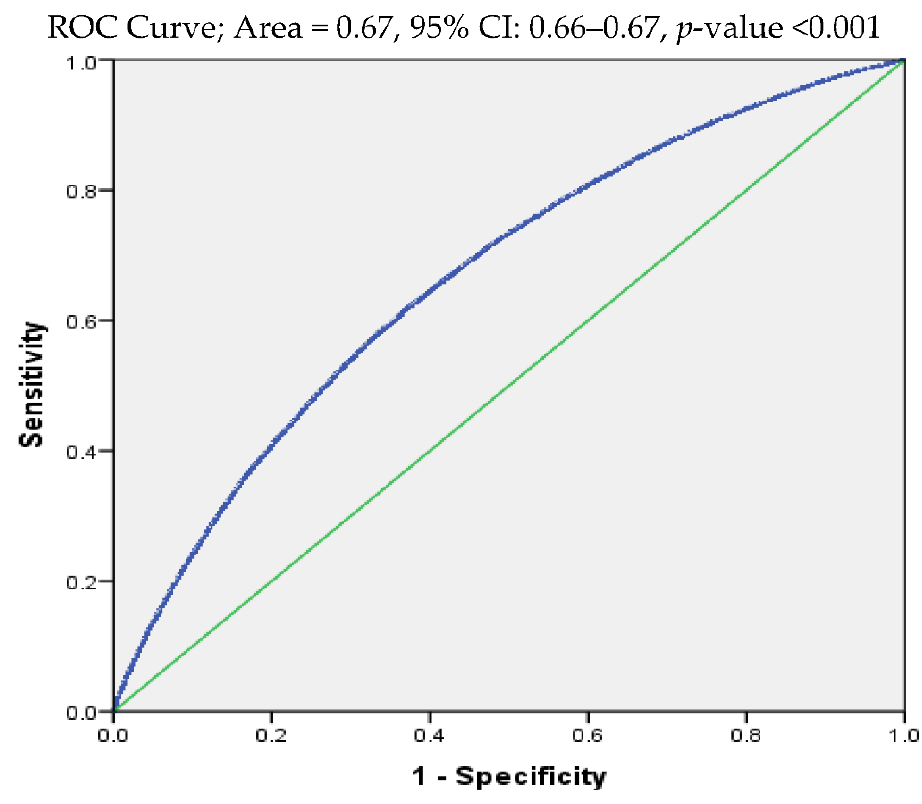
Figure 2. Receiving operative characteristic curve highlighting the results (area under the curve: 0.67 and 95%, CI: 0.66 – 0.67).